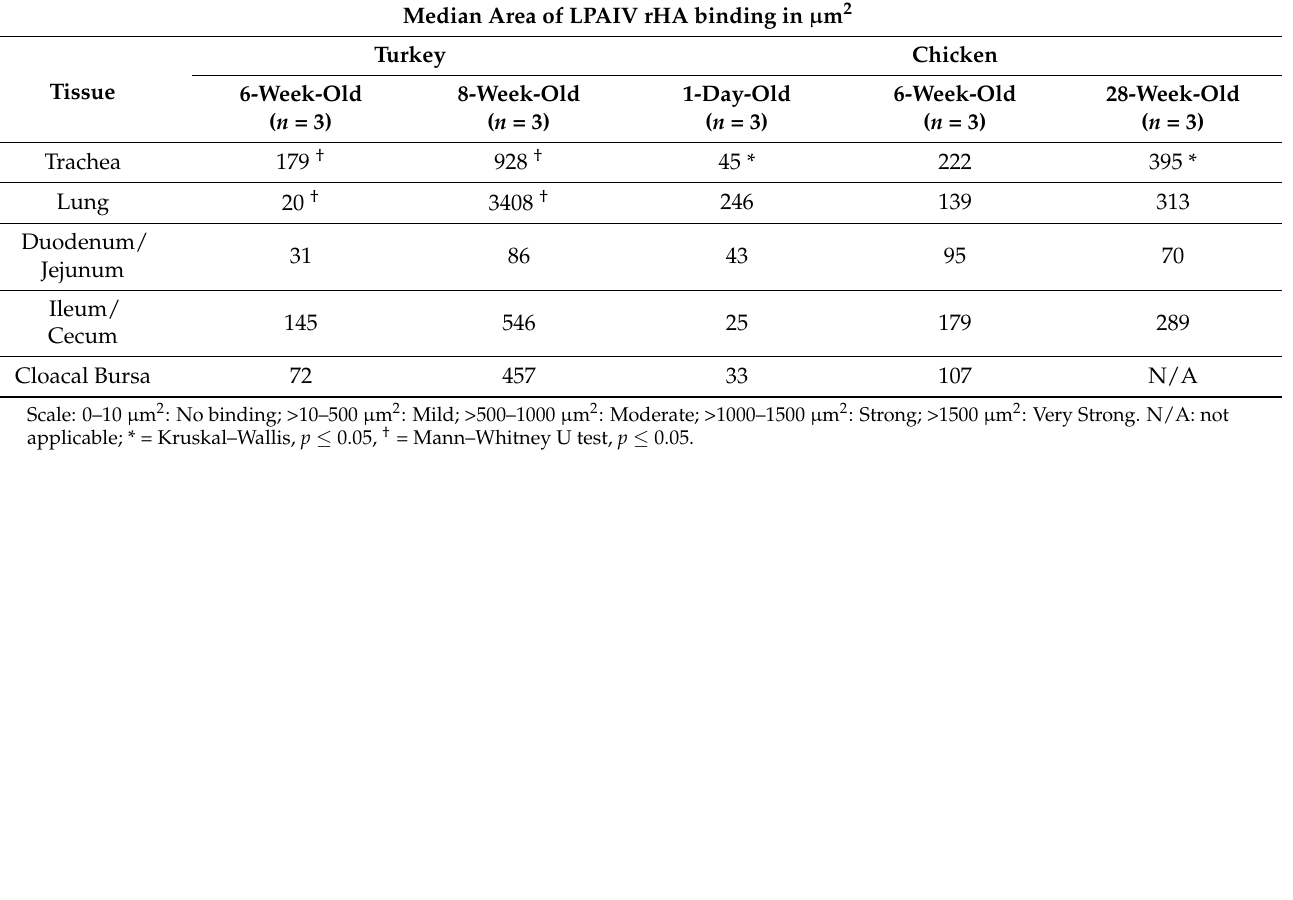
Table 4. Median area of binding (MAB) in µ m 2 of LPAIV rHA binding in the trachea, lung, small intestine, large intestine, and cloacal bursa of turkeys and chickens of different age